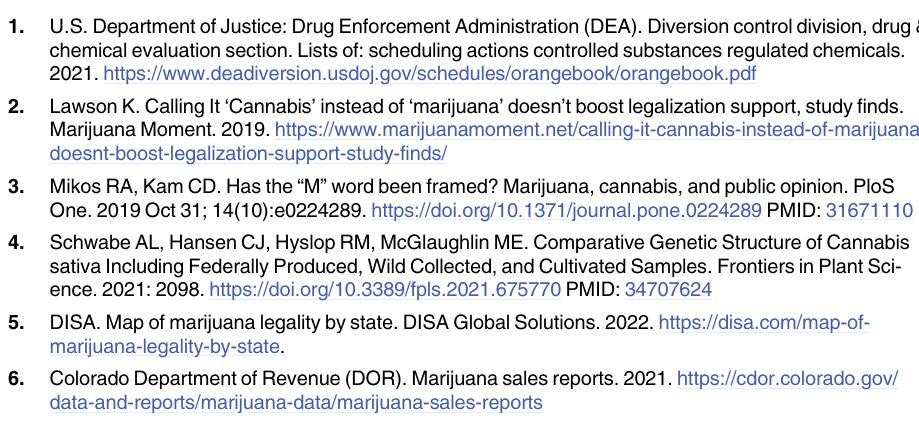
S1 Table. Raw data from HPLC testing conducted by Mile High